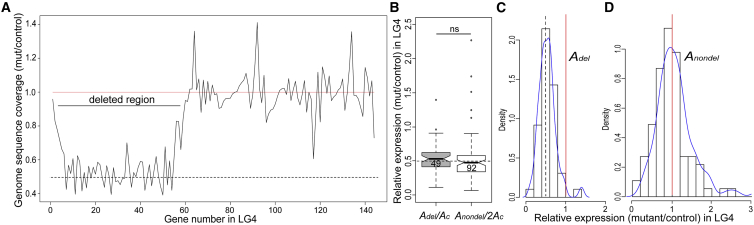
No Evidence for Dosage Compensation in Genes Deleted from Autosomal Linkage Group 4 (LG4) in Leaf Transcriptomes(A) Graph showing genome sequencing coverage for LG4. The genes are ordered according to their position on LG4.(B–D) The autosomal genes within the heterozygous deletion (Adel) are expressed at ∼50% of their total expression in controls (Ac) that are homozygous for no deletion, indicating no dosage compensation in this region. Anondel denotes autosomal genes on LG4 outside the deletion in the mutant mut3-98. Anondel expression for each gene was halved, and Adel and Anondel values were normalized by expression of the same genes in the controls. The numbers of genes analyzed in each category are shown inside the boxes. The box in this box-and-whisker plot (B) spans the first quartile (Q1) to the third quartile (Q3); the line inside the box shows the median; the notches represent the 95% confidence interval for the median; and whiskers show the range between Q1 − 1.5 × (Q3 − Q1) and Q3 + 1.5 − (Q3 − Q1). (C) and (D) show the probability density histograms (with kernel-smoothing function) for Adel and Anondel genes, respectively. (B), (C), and (D) are based on the same gene expression data in the mutant mut3-98 relative to control. The dashed line at 0.5 in (A), (B), and (C) show the expectation for deleted (hemizygous) region, while the red line at 1 in (A), (C), and (D) shows the expectation for non-deleted region.Data are listed in Table S3.